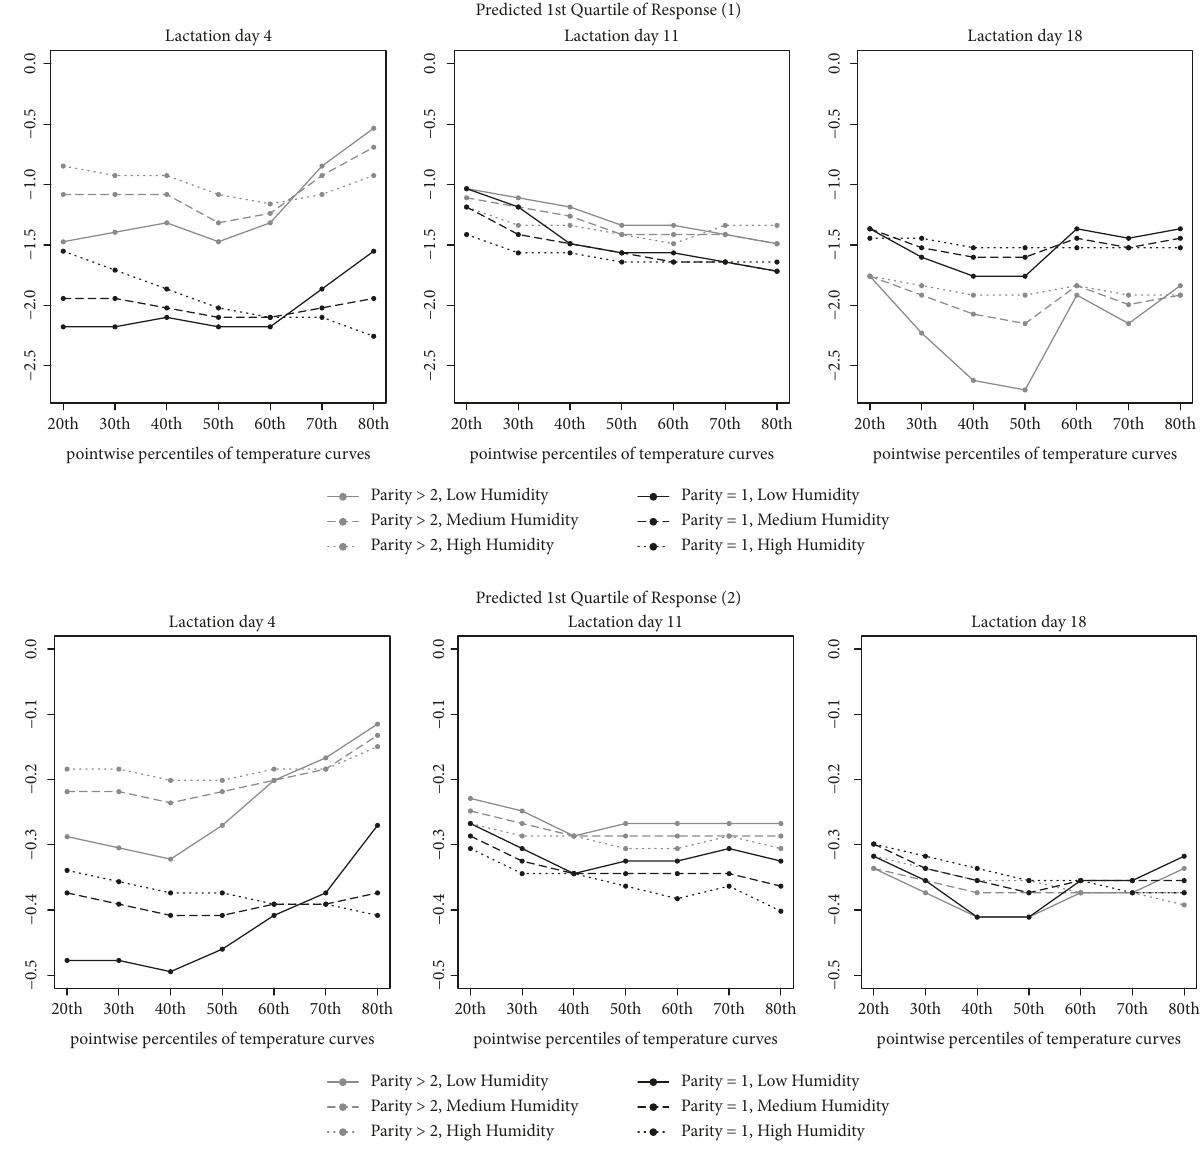
Figure 4: Displayed are the predicted quantiles of Δ (1) 𝑖(𝑗+1) and Δ (2) 𝑖(𝑗+1) for different parities, average humidity, and temperature levels. In each of all six panels, black thick lines correspond to the young sows ( 𝑃 𝑖 = 1 ) and grey thin lines correspond to the old sows ( 𝑃 𝑖 = 0 ). Line types indicate different average humidity levels; solid, dashed, and dotted correspond to low, medium, and high average humidity levels (given by the first quartile, median, and the third quartiles of 𝐴𝐻 𝑖𝑗 ), respectively. The seven grids in 𝑥 -axis of each panel correspond to the 7 temperature curves given in the respective panel of Figure